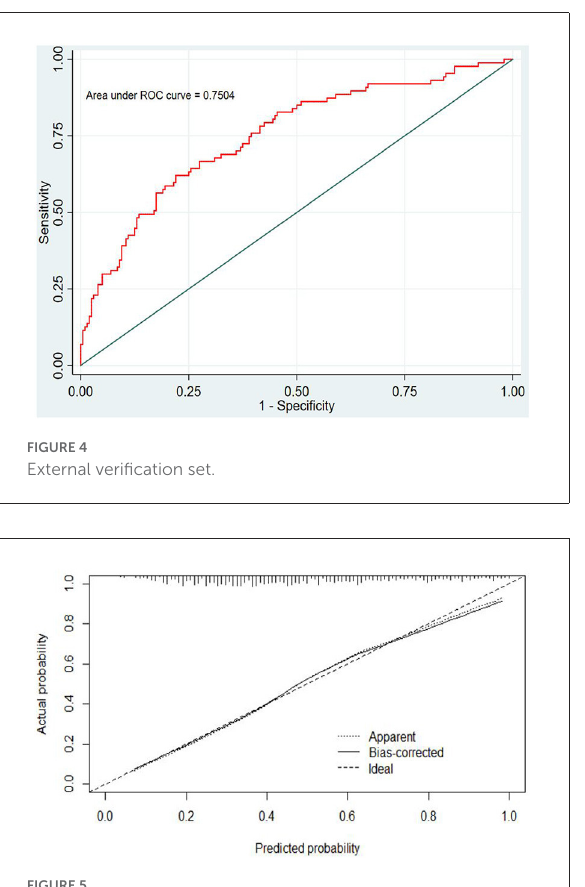
FIGURE5 Calibration curve for the model